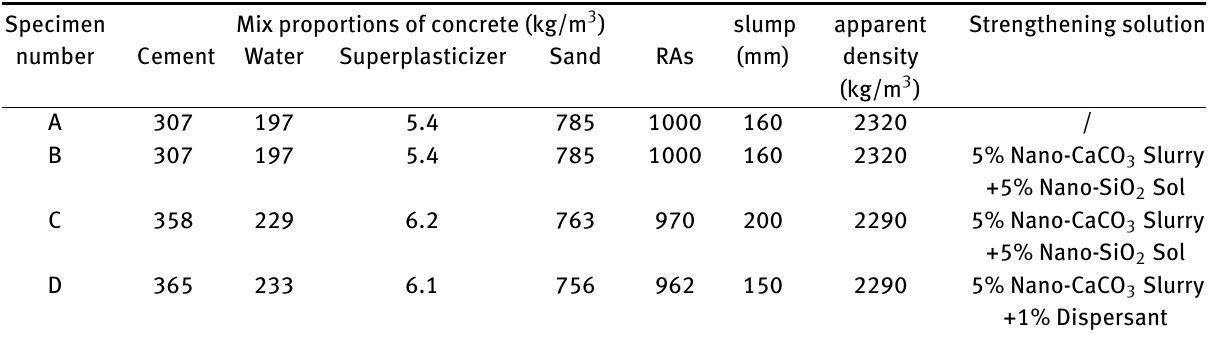
Table 3: Mix proportions and physical properties of recycled concrete Specimen